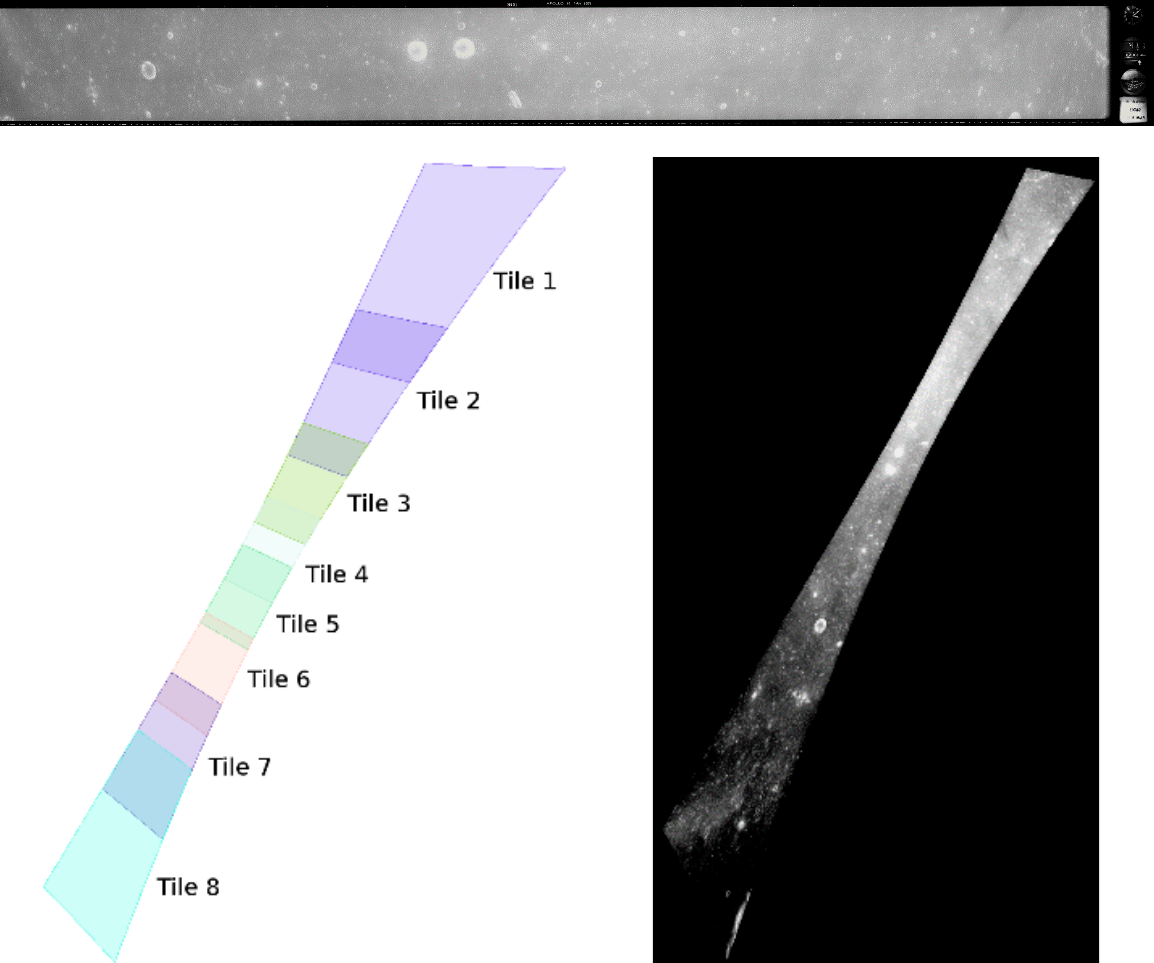
Figure 9: Top - Apollo 15 PC image AS15-P-9851, oriented 12.5 ° aft and centered at ~10 ° .78S, 34 ° .04E over Mare Tranquillitatis (NASA/JSC/ASU). Projected footprints (bottom left) and mosaic (bottom right) of image tiles 1-8 after application of a priori position and pointing kernels. Projection is